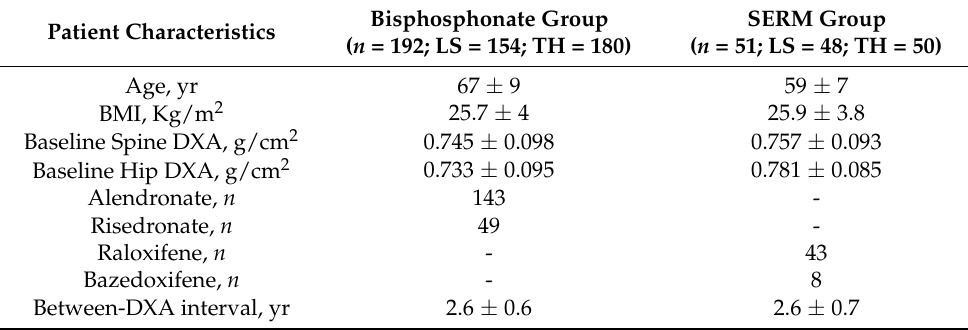
Table 1. Study population. LS, lumbar spine DXA; TH, total hip DXA. Patient